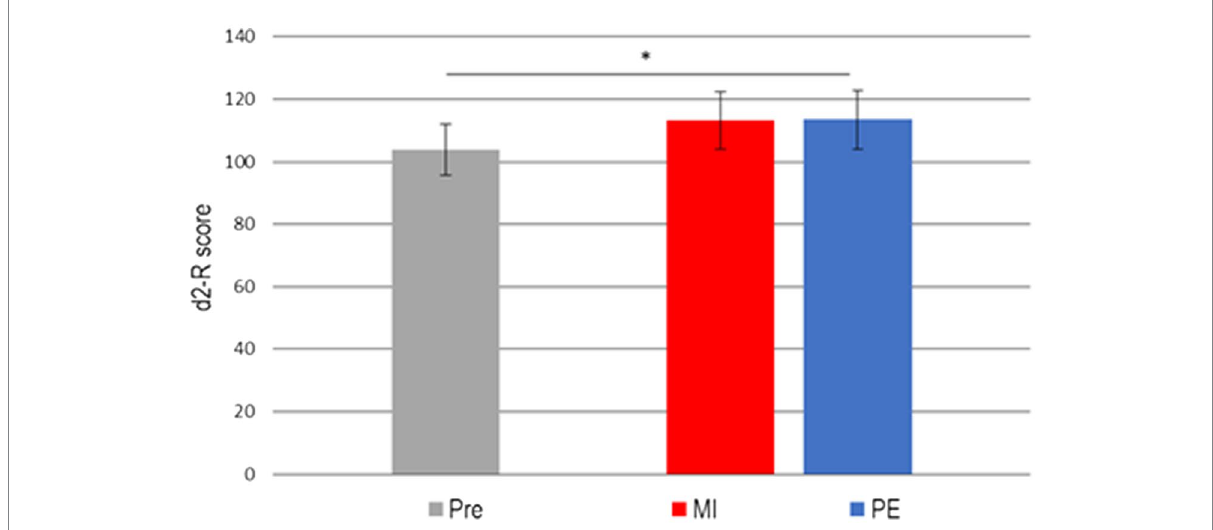
FIGURE 2 Mean (±SD) d2-R score before (Pre) and after MI or PE exercise. Significant difference (* p < 0.05) between pre and both post MI and post PE.